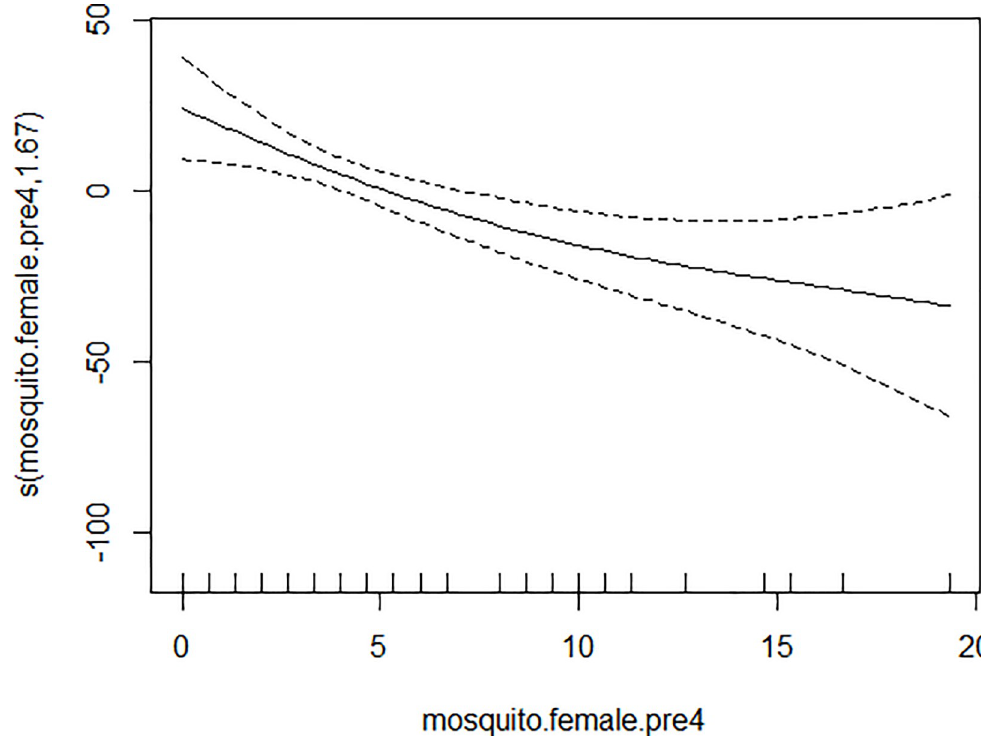
Fig 3. The relationship between BI and female Ae . albopictus density pre 4